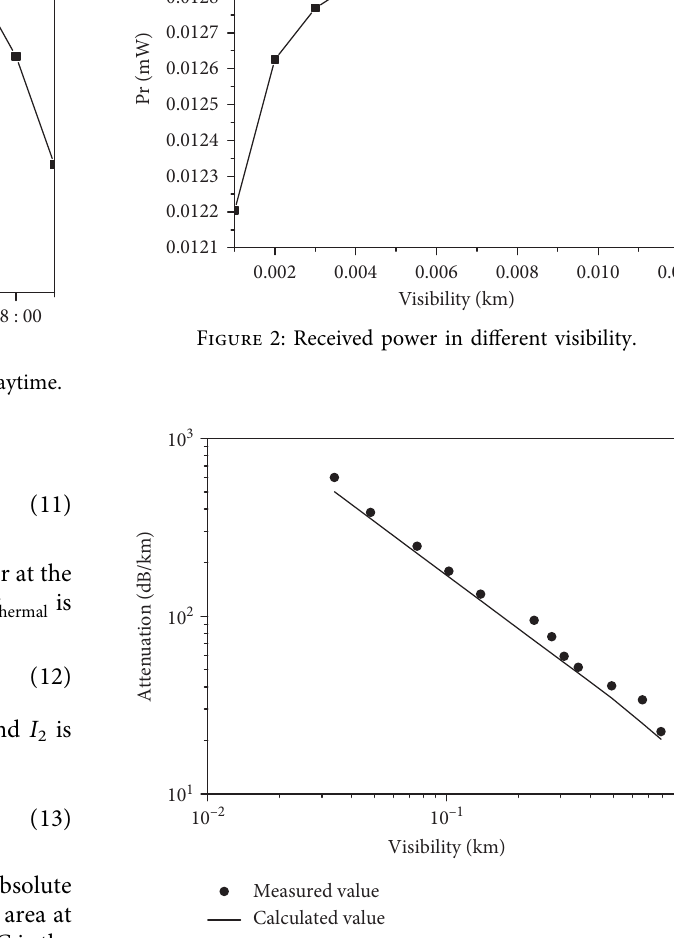
Figure 3: Comparison of the measured value and the theoretical value of the attenuation